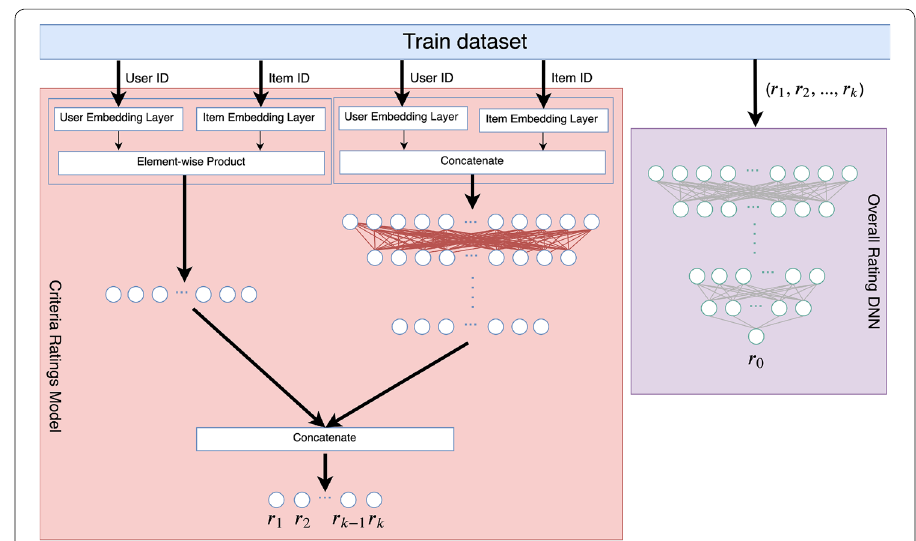
Fig. 2 The architecture of the two models: Criteria Ratings Model and Overall Rating